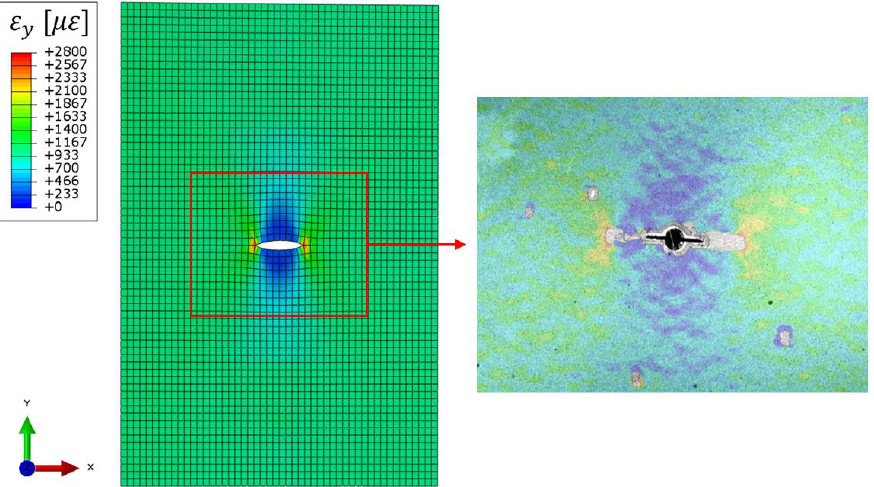
Figure 14. Comparison between iFEM strain reconstruction and the DIC strain field with the same color scale. Acquisition performed at 20,000 cycles: real crack length (DIC) of 24.30 mm and iFEM crack length of 24 mm. Inverse FEM deformed shape with a scale factor 100.